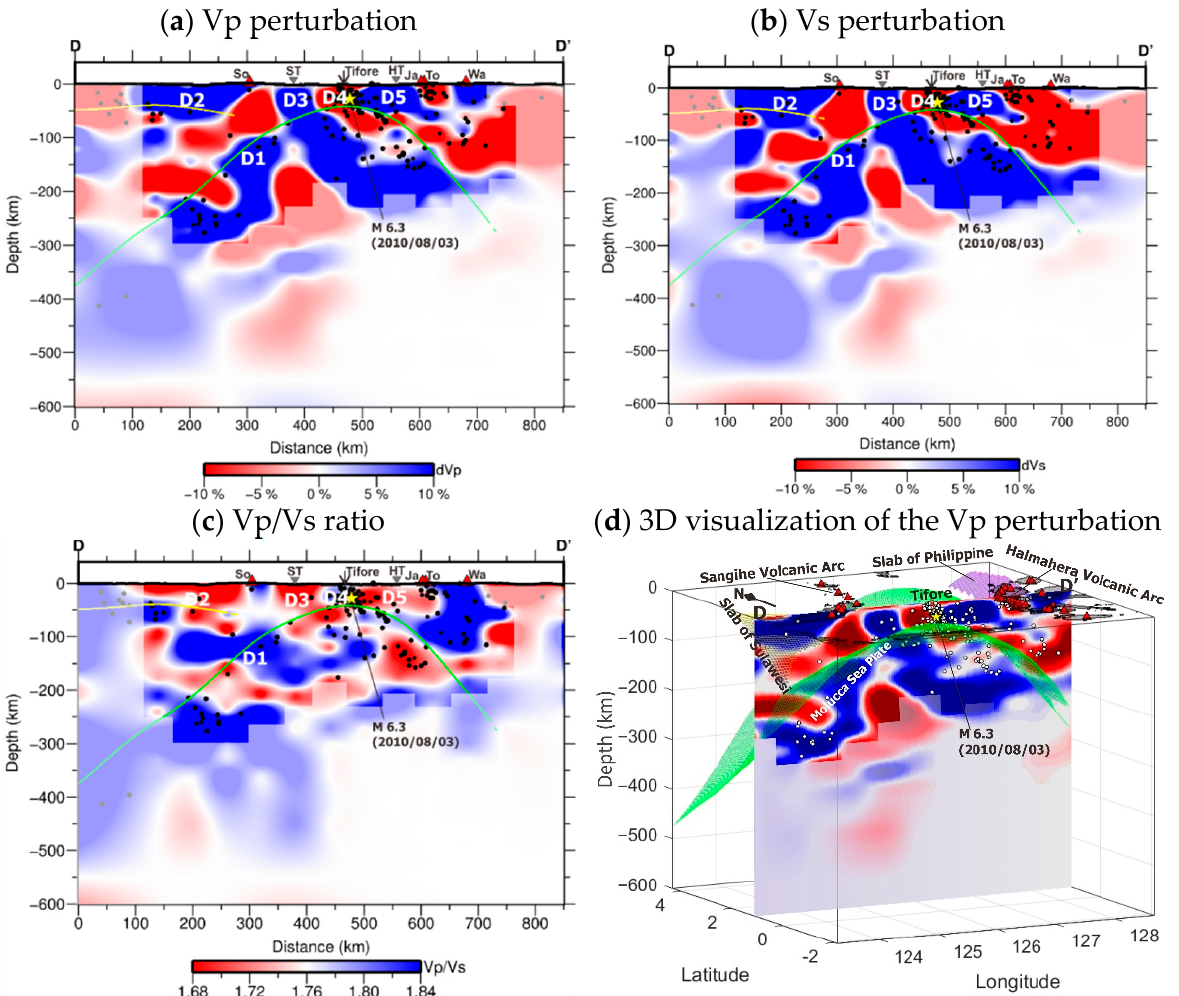
Figure 9. Vertical cross-section of D-D (cid:48) (west–east) crossing Sulawesi’s north arm, the Molucca Sea, and Halmahera Island. The red color indicates low-velocity areas and low Vp/Vs ratio, and the blue color indicates high-velocity areas and high Vp/Vs ratio. The D1, D2, D3, D4, and D5 are areas for the interpretation of tomographic inversion results. The black dots signify earthquakes within a radius of 30 km ≤ D-D (cid:48) ≤ 30 km, and the yellow star is the magnitude of a significant earthquake. The green line and the green three-dimensional surface plot are the slab2 models of the Molucca Sea Plate; the yellow line is the slab2 model of Sulawesi [45]. Thus, So: Soputan Volcano; ST: Sangihe Trench; the reserve arrow is Tifore island; HT: Halmahera Trench; Ja: Jailolo Volcano; To: Todoko-Ranu Volcano; Wa: Wato-Wato Volcano; the blurred area is an area that is not well-resolved.